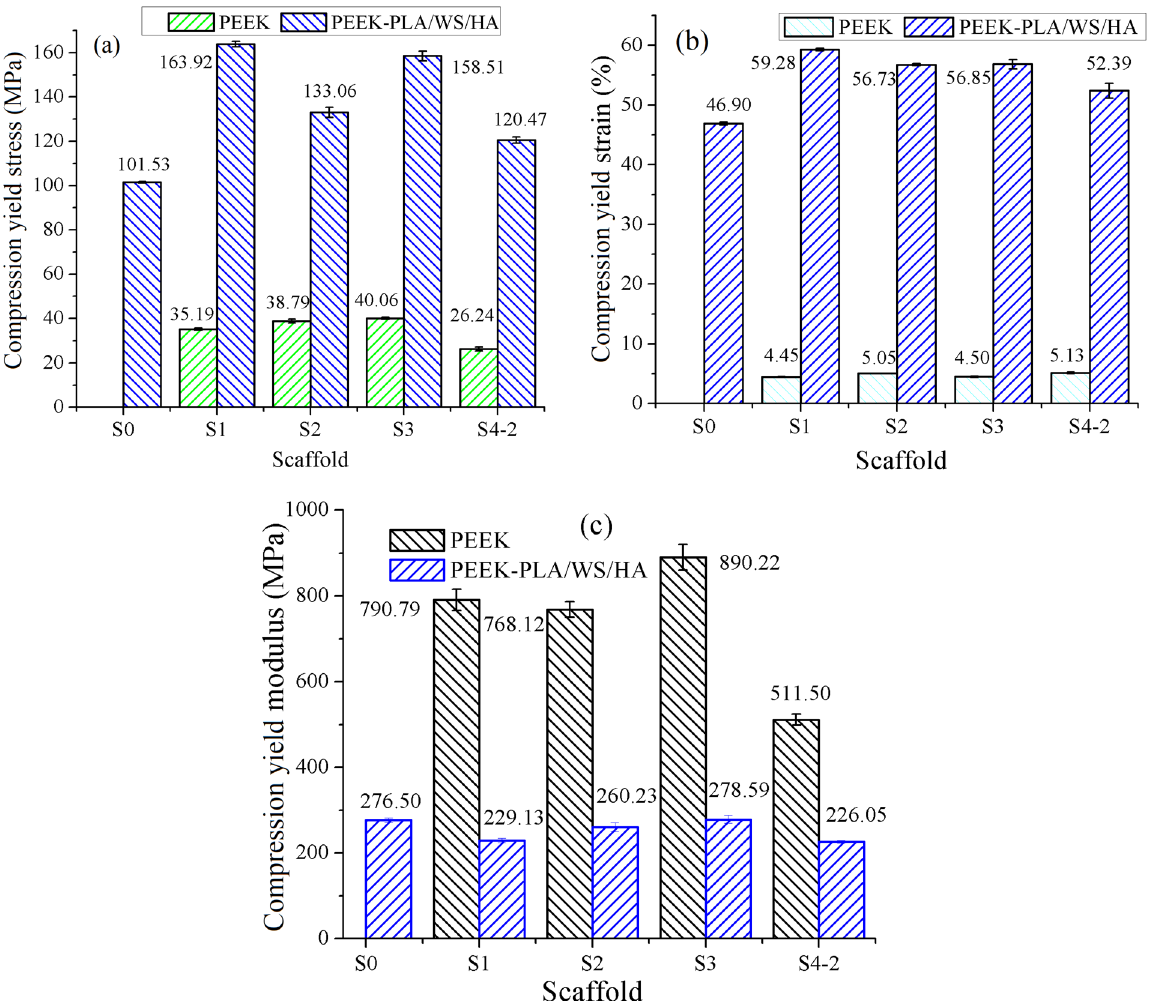
Figure 11. Compression yield properties of FFF PEEK scaffolds 26 and PEEK-PLA/WS/HA scaffolds: ( a ) stress, ( b ) strain and ( c )